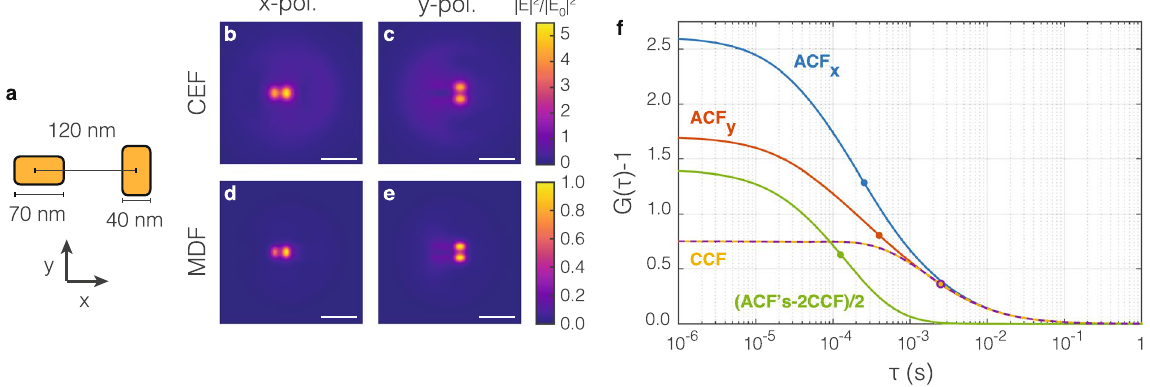
Figure 2. Nanorods for nano-antenna dual focus fluorescence correlation spectroscopy. ( a ) A sketch of the nanorod based geometry for nano-antenna 2fFCS. Two 40 × 70 nm nanorods (30 nm height) with 120 nm center to center distance form a T-shape. When placed on glass and in water, their near field response is resonant at 676 nm. ( b , c ) The near-field intensity in a plane 30 nm above the rods, upon plane wave illumination at 690 nm (targeted emission wavelength) for polarization along the horizontal ( b ) and vertical ( c ) rod. Through reciprocity, this intensity is proportional to the collection efficiency function. The scale bar is 200 nm. ( d , e ) The molecular detection efficiency reconstructed from simulations for a λ = 676 nm pump wavelength ( w 0 ≈ 300 nm Gaussian beam width) and λ = 690 nm emission wavelength (i.e., panels b,c). As a global scaling factor does not affect the correlation curves, both MDFs are normalized to the maximum in panel d). ( f ) Predicted autocorrelation functions for the intensity on the x - and y -polarized detector (blue and red curves), predicted cross-correlation between polarization channels (yellow and dashed purple), and autocorrelation of the polarization contrast (green), constructed as ( ACF x + ACF y − 2 CCF )/2. Circles indicate the time at which the correlation has dropped to 50% of its maximum value at τ =